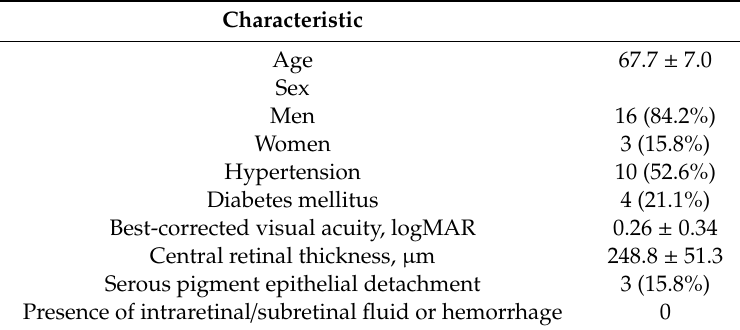
Table 1. Baseline characteristics of included patients (N = 19).